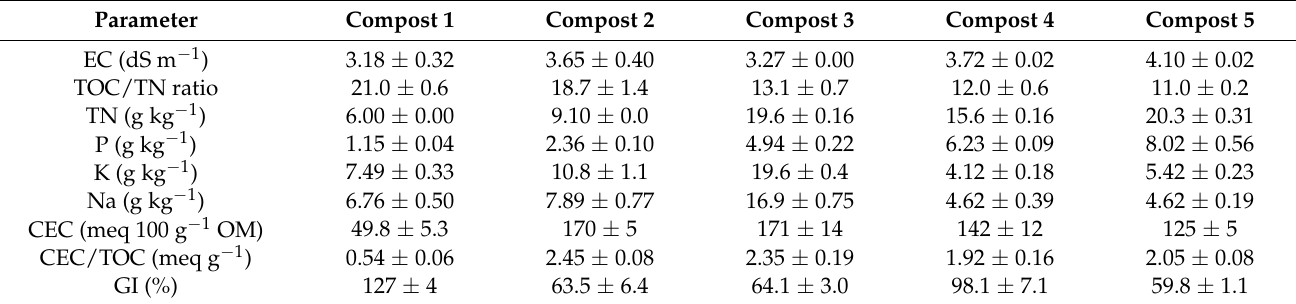
Table 5. Final agronomic characteristics (dry weight basis) of the mature composts. Parameter Compost 1 Compost 2 Compost 3 Compost 4 Compost